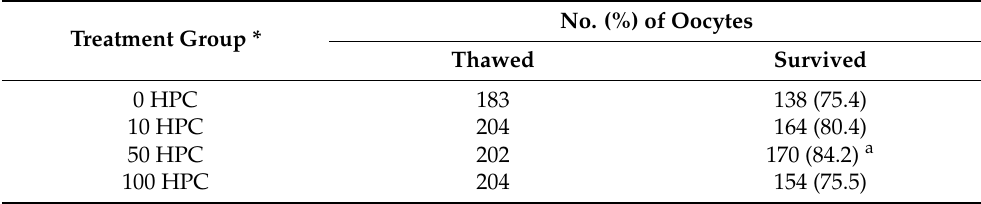
Table 2. Survival of bovine MII oocytes after vitrified-thawed ( n =